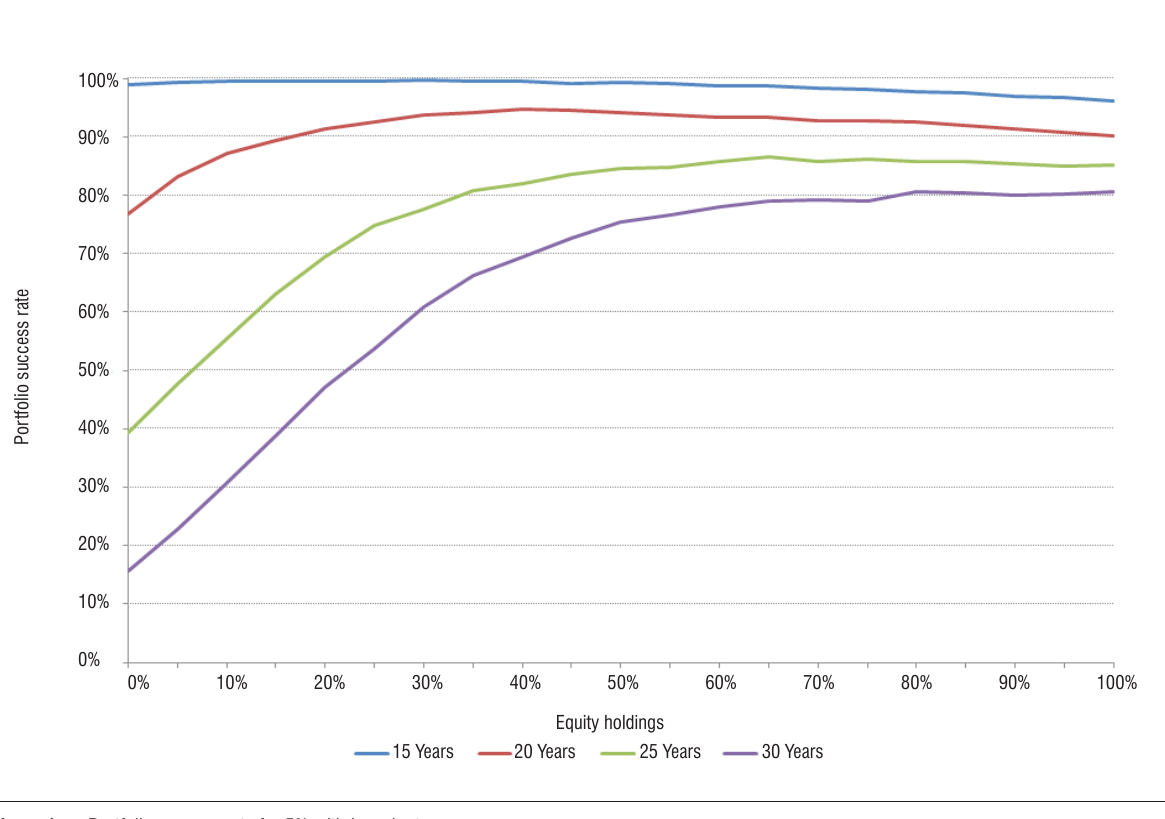
Figure 1: Portfolio success rate for 5% withdrawal rate.